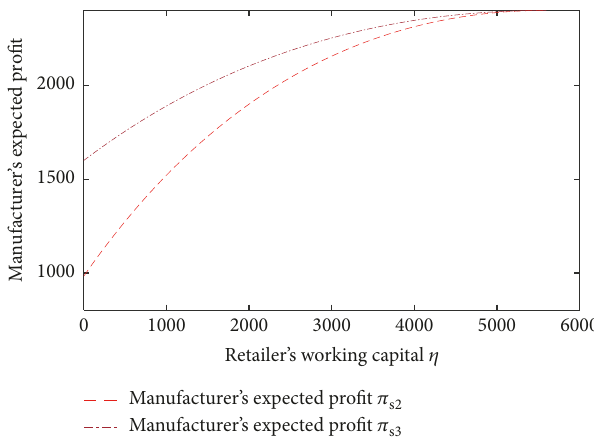
Figure 6: Change trend of manufacturer’s expected profit with retailer’s working capital 𝜂